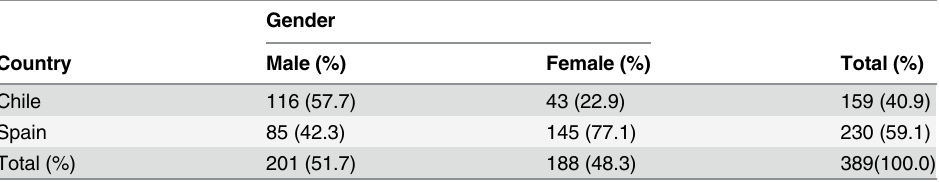
Table 1. Descriptive statistics of the